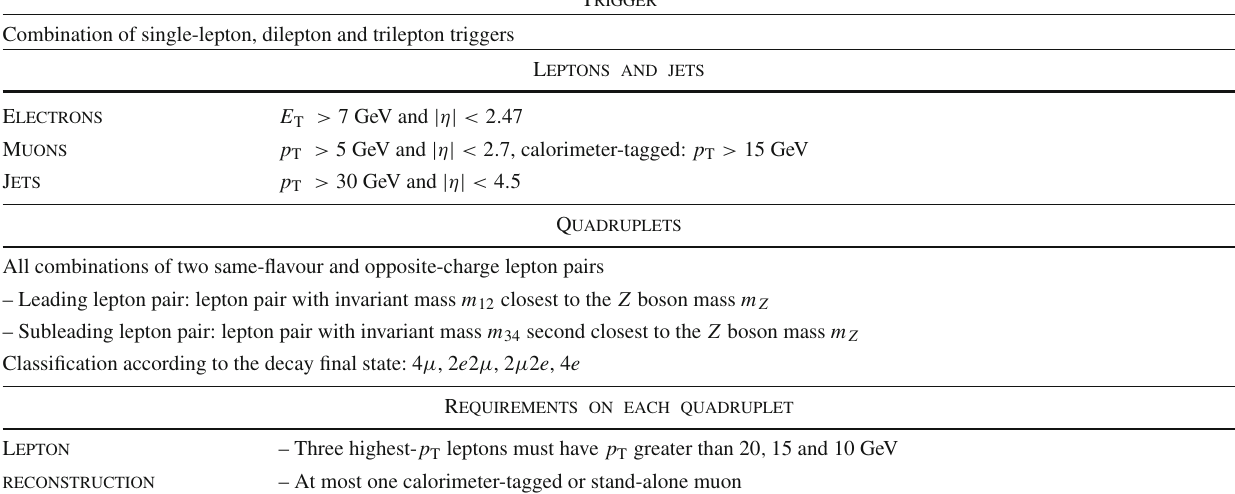
Table 3 Summary of the criteria applied to the selected Higgs boson candidate in each event. The mass threshold m min is defined in Sect. 4.1 Combination of single-lepton, dilepton and trilepton triggers